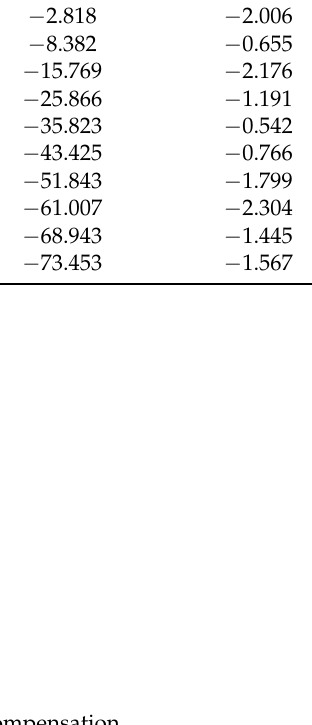
Figure 12. The finished counterpart with compensation. Table 4. The measured coordinates and conversion coordinates of counterpart with compensation.